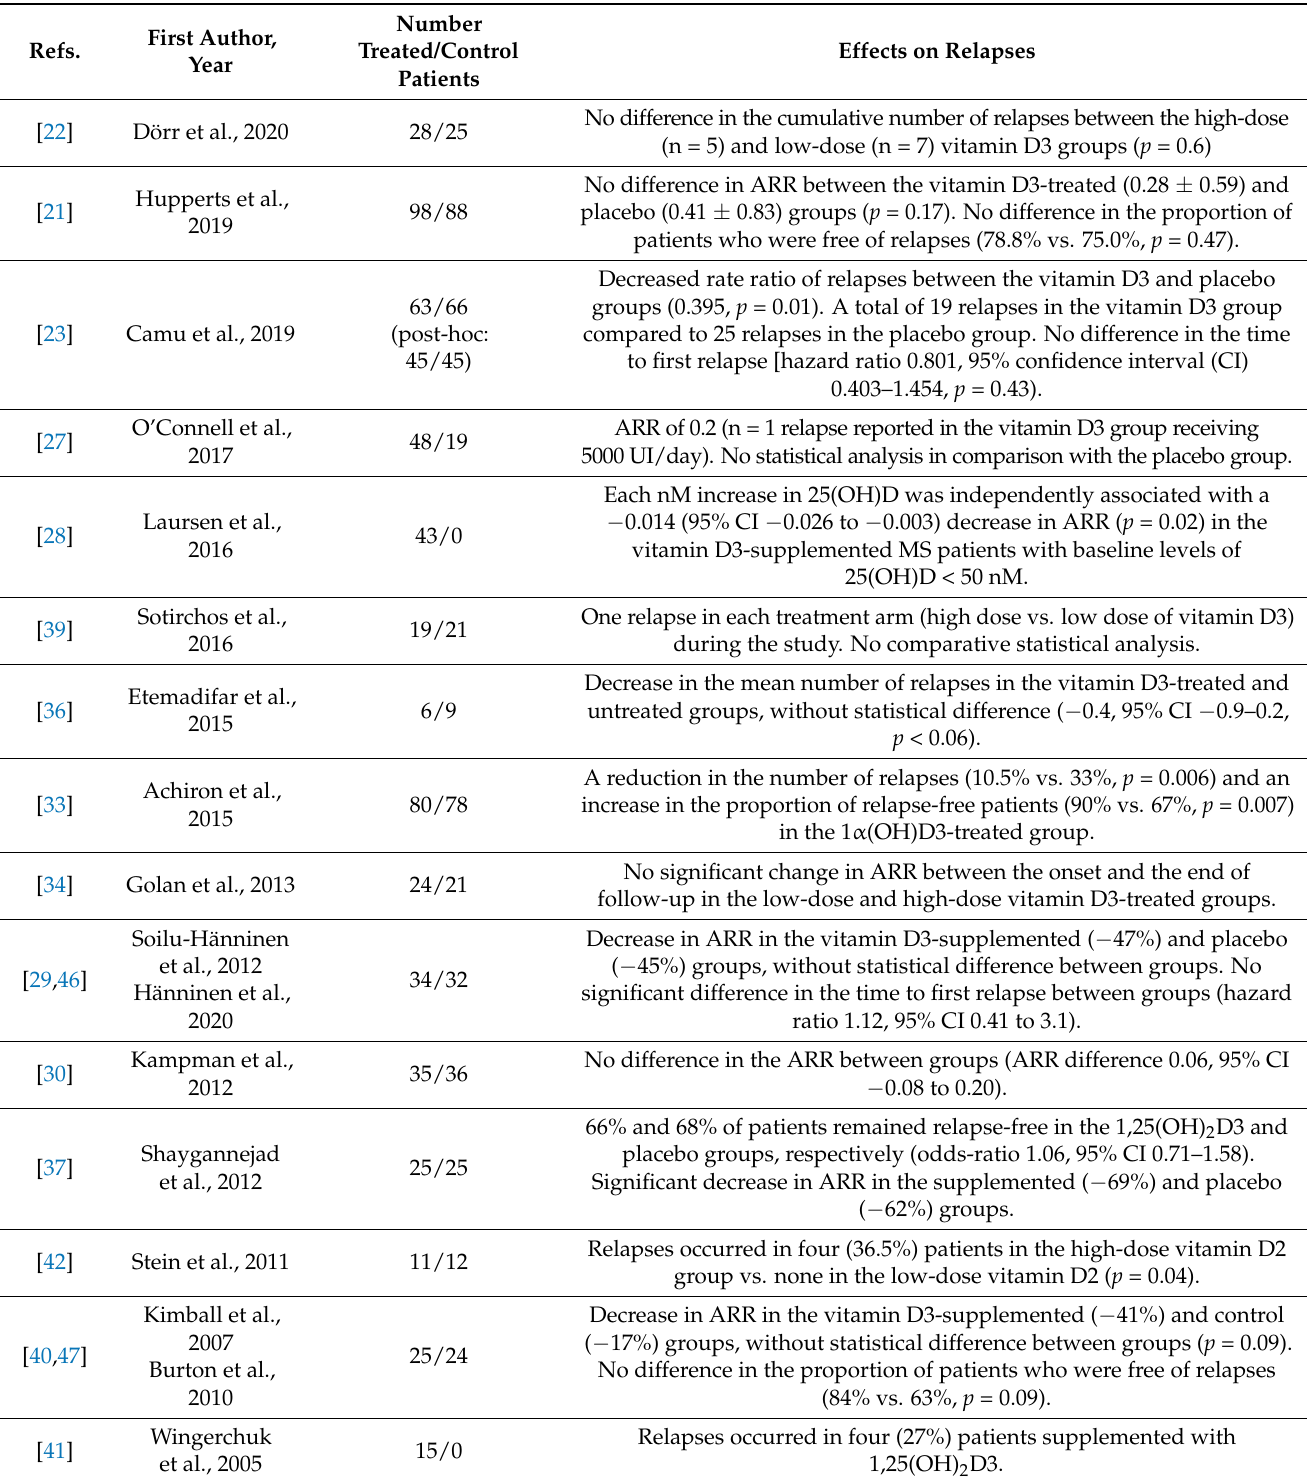
Table 5. Summary of observations on relapses after vitamin D supplementation in MS